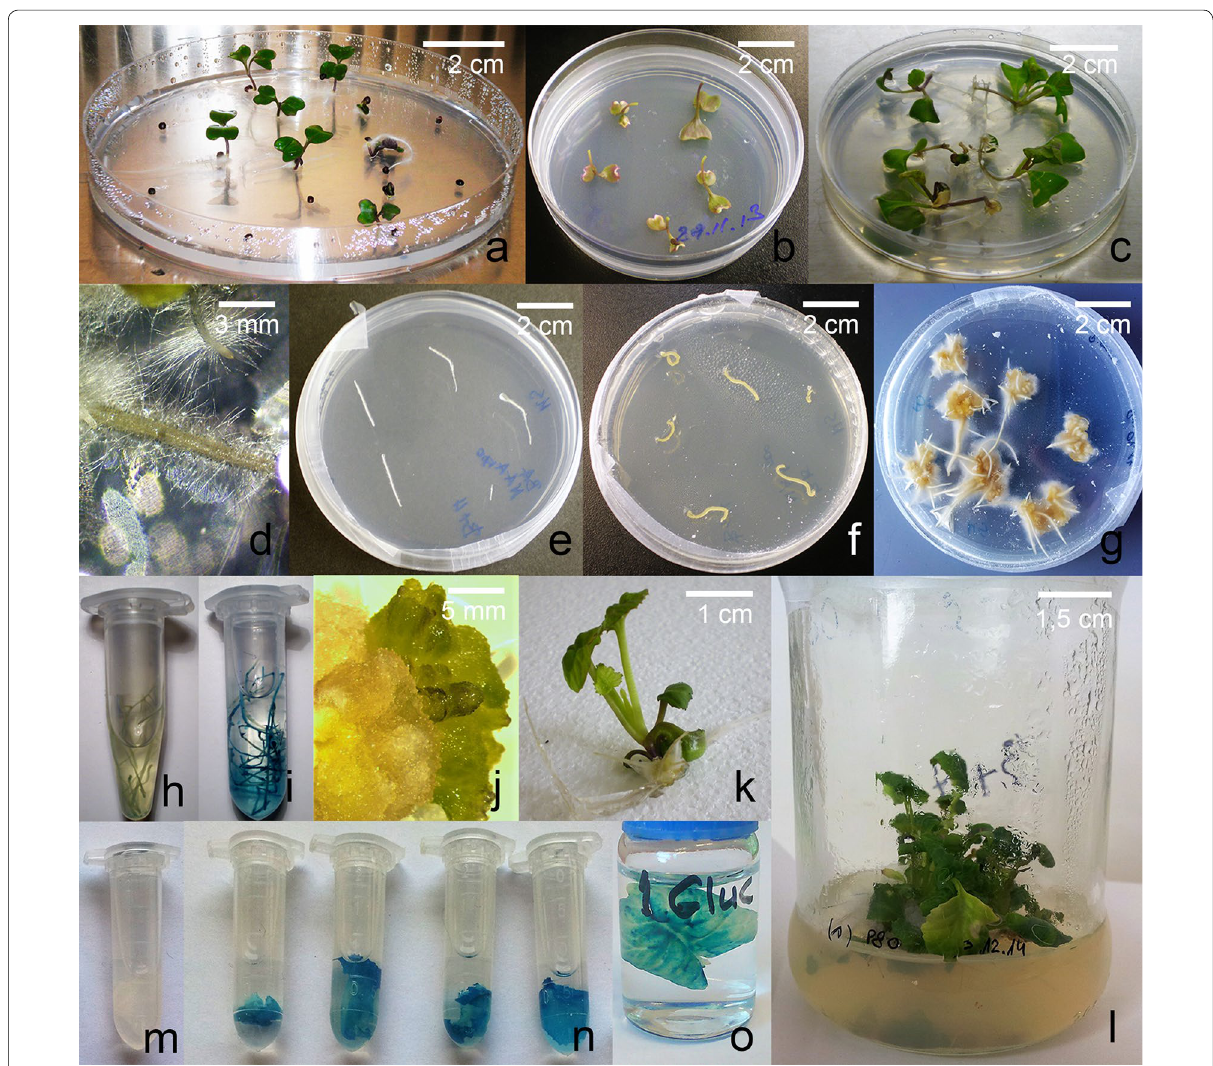
Fig. 1 The process of R. rhizogenes ‑mediated transformation, regeneration and analysis of the B. oleracea var. botrytis ( Pionier cultivar) plants (scheme for the A4 strain). a Cauliflower seed germination; b hypocotyls of the derooted seedlings after bacteria dropping; c hairy root induction on the hypocotyls; d an individual hairy root; e – g stages of the transgenic hairy root multiplication; h , i the GUS assay on the hairy root clones, wild type negative control and the tested probe respectively; j indirect organogenesis on the transgenic callus obtained on the hairy root cultures; k shoot development; l rooting of the transgenic cauliflower shoots; m – o histochemical analysis of the cauliflower leaves, wild type negative control and the tested probes